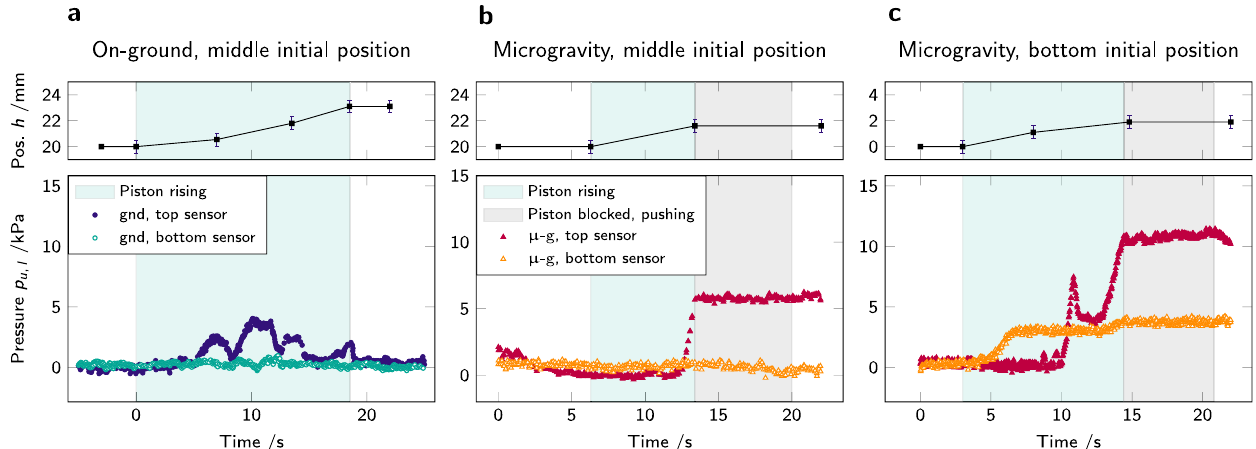
Fig. 4 Pressure evolution with piston rise. a (gnd) and b , c in microgravity ( μ -g). The pressure p u , l (bottom graphs) is recorded by sensors in two positions: on the top part of the cell ( p u : fi lled marks, gnd in blue and μ -g in red) and on the bottom part of the cell ( p l : open marks, gnd in green and μ -g in orange). On a , b the piston starts in the middle of the cell (position h ≈ 20 mm), while on c it starts at the bottom of the cell ( h = 0 mm): on a and b the pressure sensors are distributed one above the piston and one below, while on c both sensors are above the piston. On a t = 0 s represents the start of piston rise; on b , c , t = 0 s represents the start of the microgravity phase. The pressure evolution exhibits repeated yielding on-ground, while the packing jammed in microgravity remains stable, even at maximum load. In the top graphs, the error bars represent the experimental precision in optical